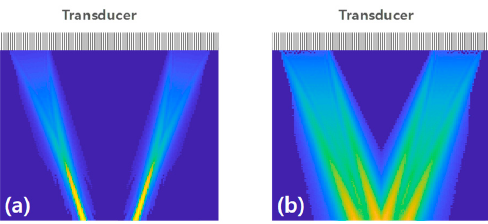
Figure 2. Transmitted ultrasound beam profiles of the ( a ) focused beam and ( b ) plane wave in the liquid. An array transducer was on top of the pipe.